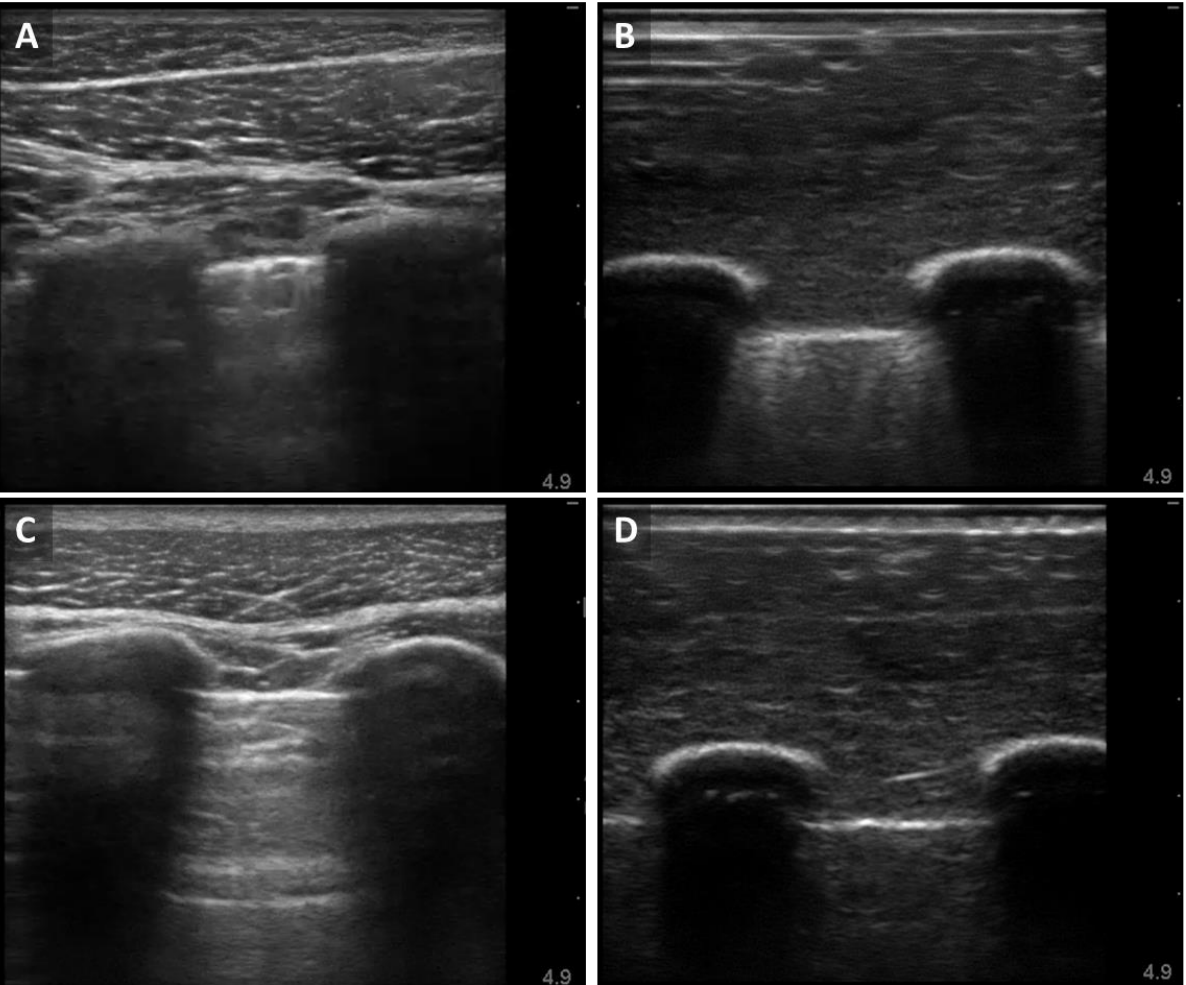
Figure 3. B-mode image comparison with euthanized porcine subjects and synthetic phantom: ( A ) Baseline thoracic image acquired from porcine subject; ( B ) Baseline image acquired from rib and lung phantom apparatus; ( C ) Post-injury image acquired from same porcine subject; ( D ) Pneumotho- rax positive image acquired from synthetic phantom